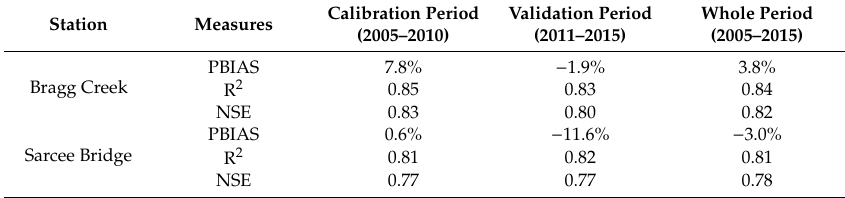
Figure 4. Comparison of periodic daily simulated and observed stream temperatures for the ( a ) Bragg Creek station and ( b ) Sarcee Bridge station. Table 2. Model performance statistics for periodic daily stream temperature in the